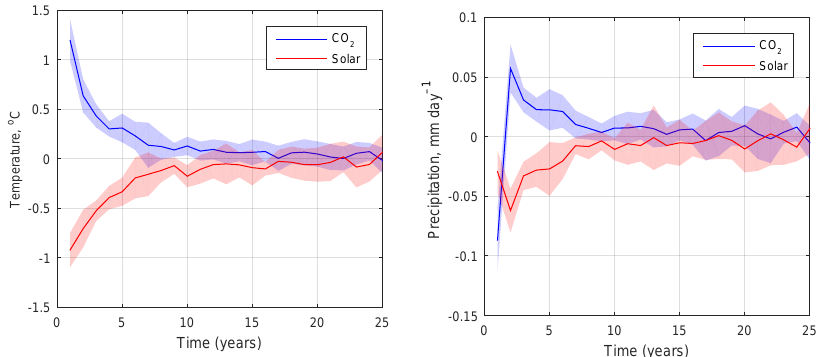
Figure 2. Estimated impulse response for CO 2 and solar forcing, for global-mean temperature and precipitation, averaged over all nine mod- els (Table S1); the inter-model standard deviation is shown by the shaded bands. While these impulse response functions are “noisy”, predictions made using them are less so, particularly for forcing levels much smaller than those used in estimating these functions. Note for precipitation the robust “fast” response to increased CO 2 has the opposite sign as the “slow” response. Temperature and precipitation units are given as the response for a quadrupling of CO 2 . (See Supplement, including Fig. S1, for individual model impulse response